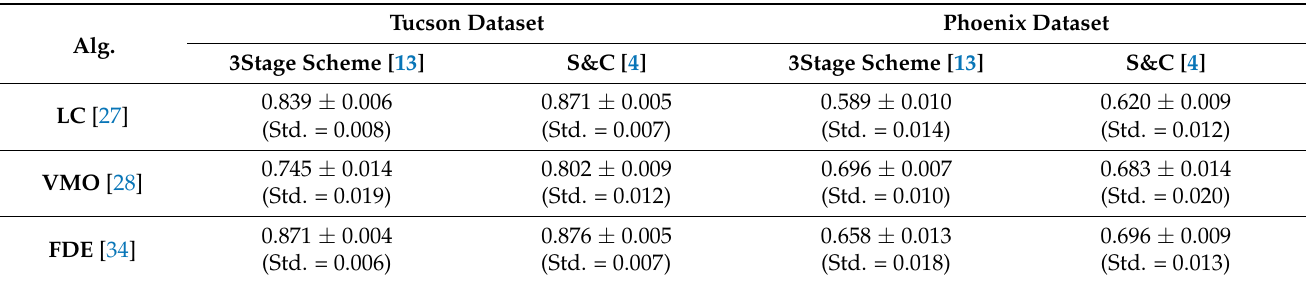
Table 2. Statistical test on average F-score (10 × 10 frames): two post-processing schemes associated with three automatic detection